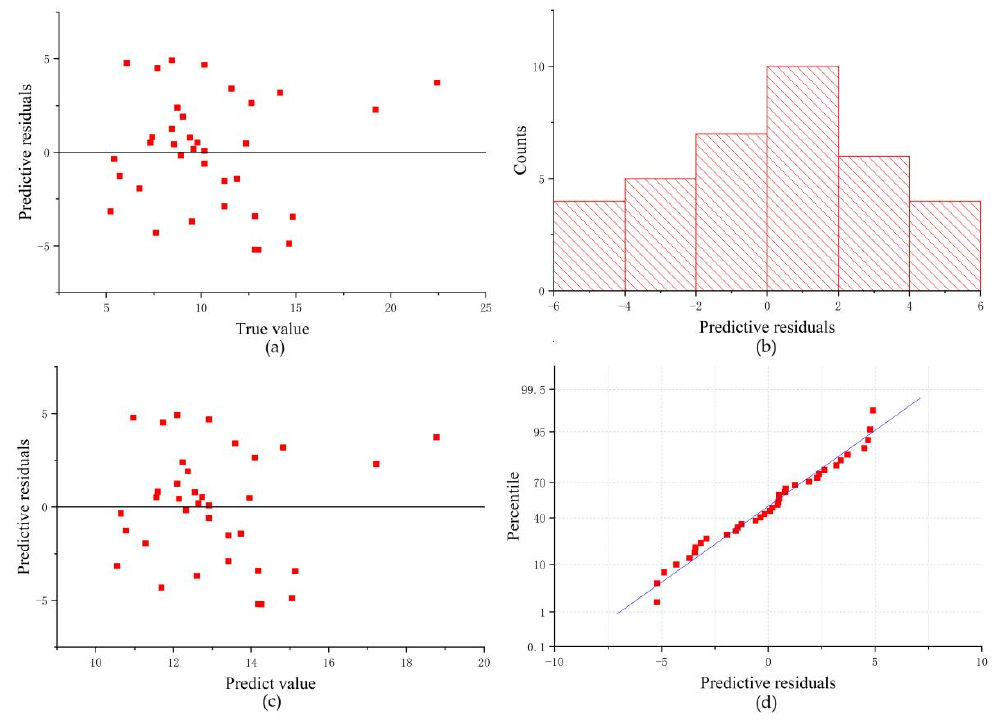
Figure 16. DEM differential interference method with multilayer perceptron estimation of height residuals: ( a ) predicted residuals of true tree height; ( b ) counts of predicted residuals; ( c ) predictive residuals of predicted value; ( d ) percentile of predictive residuals.